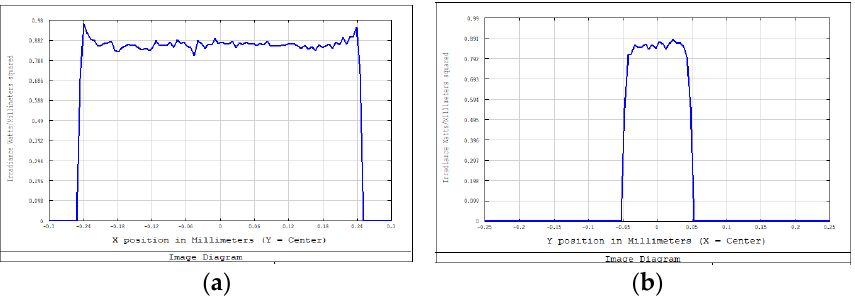
Figure 12. Light-field-intensity distribution of the focusing system with a working distance of 500 mm. ( a ) Light-field-intensity distribution in the X-direction. ( b ) Light-field-intensity distribution in the Y-direction.